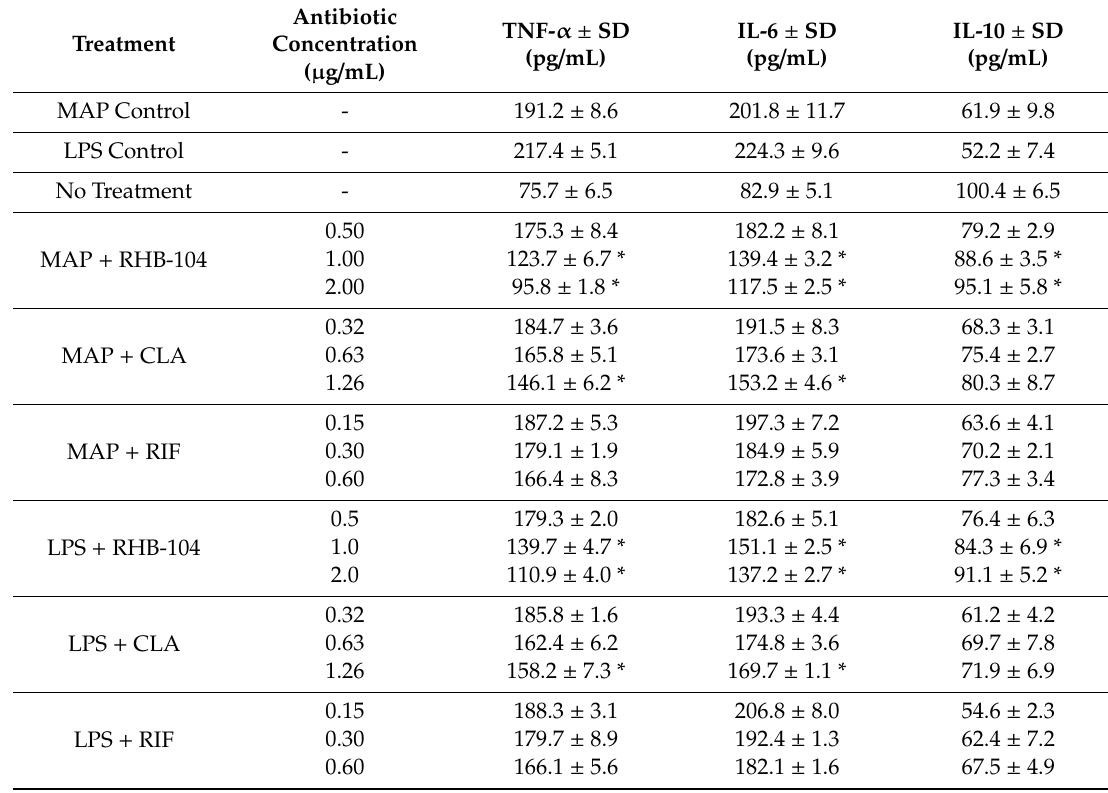
Table 3. Measurement of TNF- α , IL-6 , and IL-10 cytokines in macrophages infected with MAP or treated with LPS following treatment with RHB-104 and its major